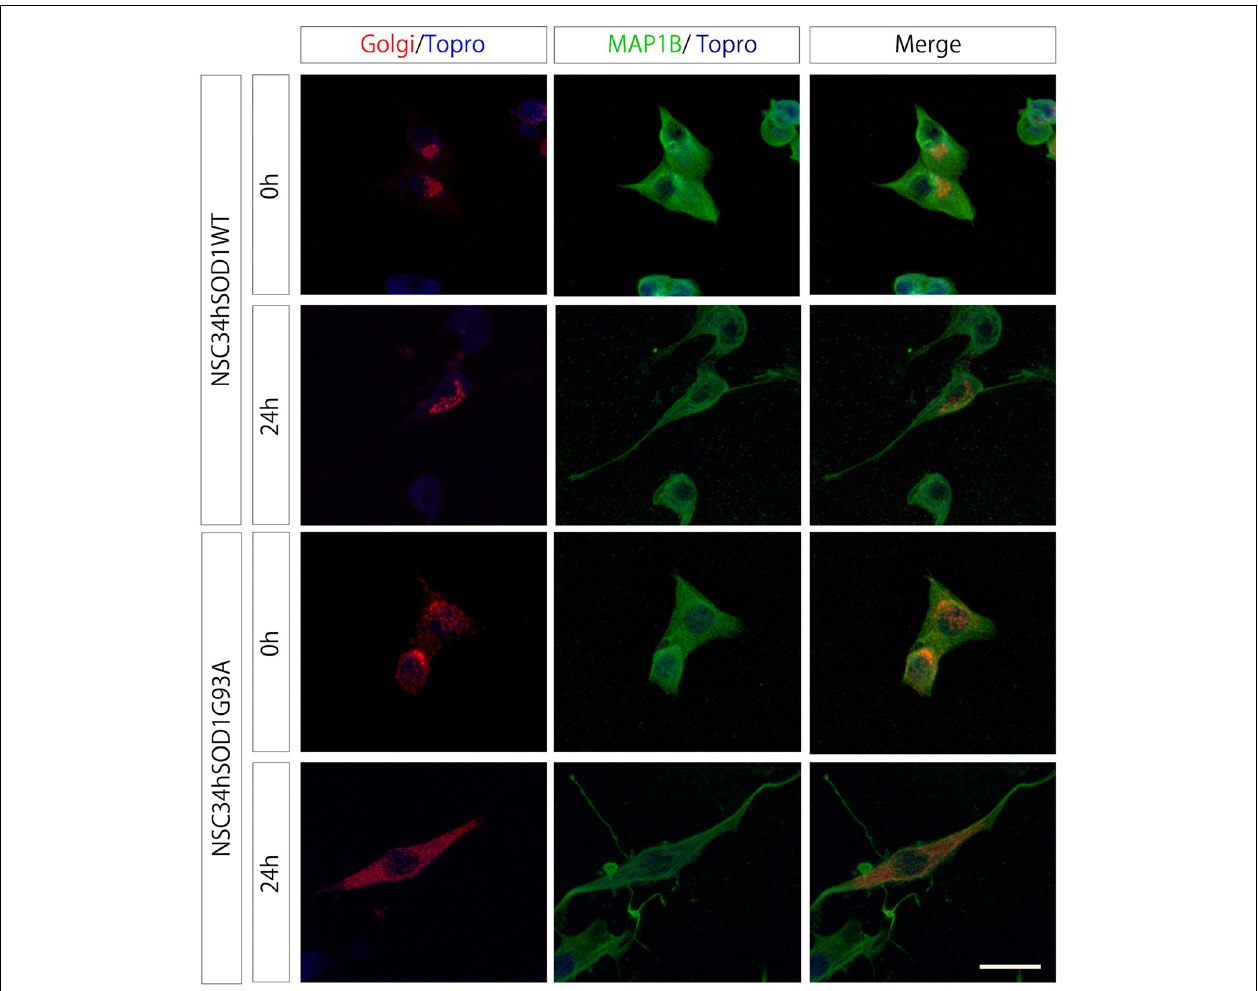
FIGURE 3 | NSC34hSOD1G93A cells display Golgi disruption. NSC34hSOD1 cells were transfected with the FU-Golgi-mRFP vector, and fixed at 0 and 24 h of differentiation to determine the